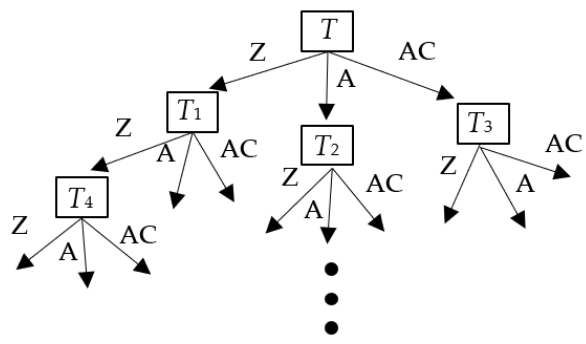
Figure 4. Search Tree obtained from Method 1.